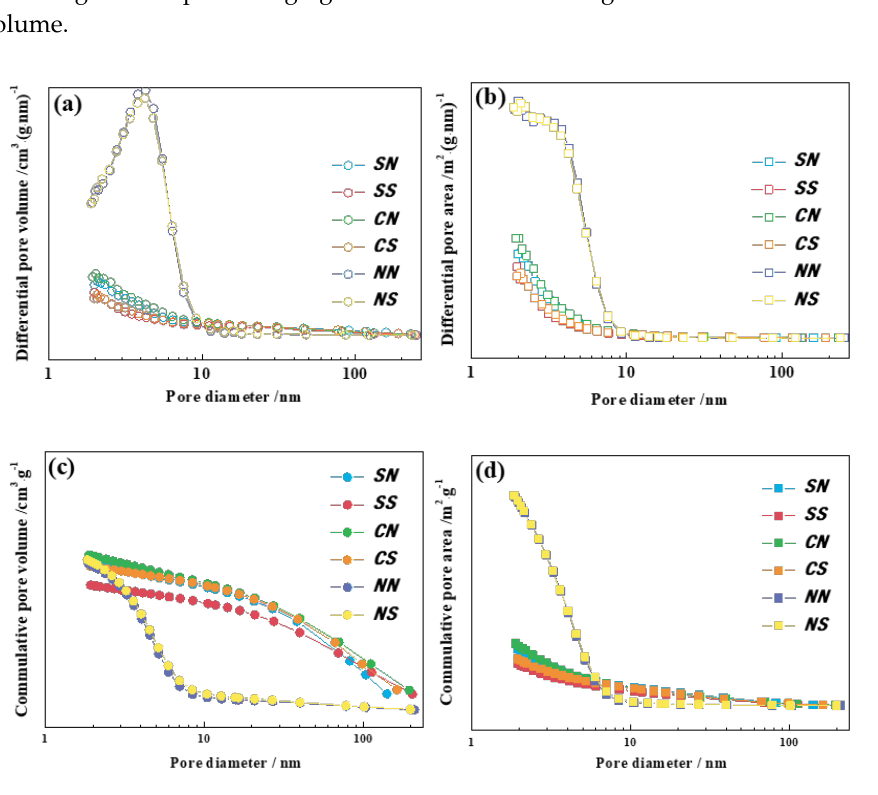
Figure 3. Distribution characterization of pore structures over titanium modified FeMgO x catalysts with di ff erent precursors: ( a ) Pore volume, ( b ) Pore area, ( c ) Cumulate pore volume and ( d ) Cumulate pore area.